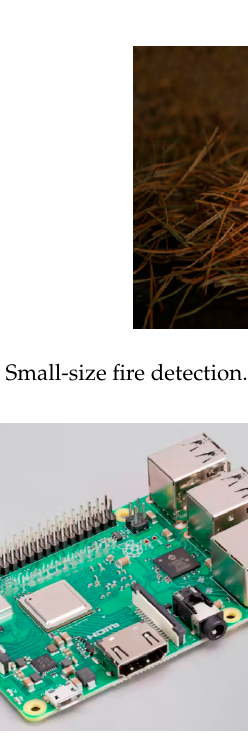
Figure 12. Characteristics of Raspberry Pi 3B+.